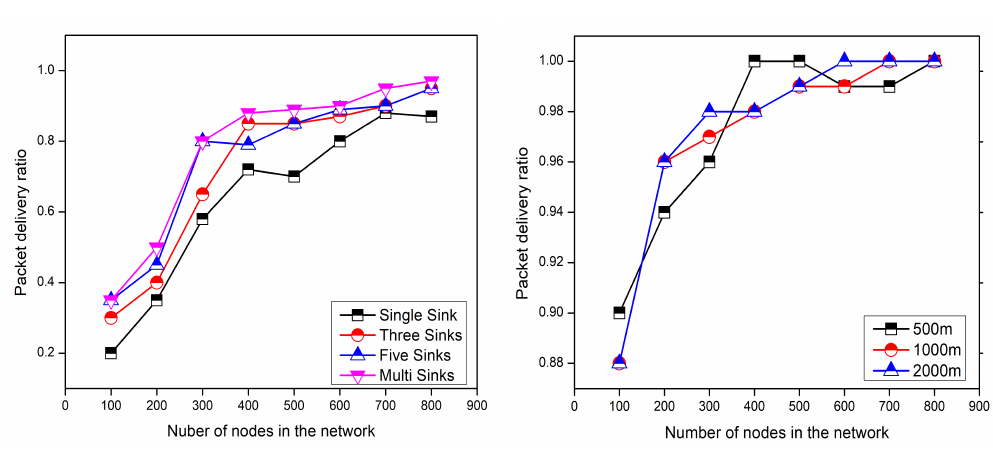
Figure 5. Performance analysis of proposed framework for packet delivery ratio in different